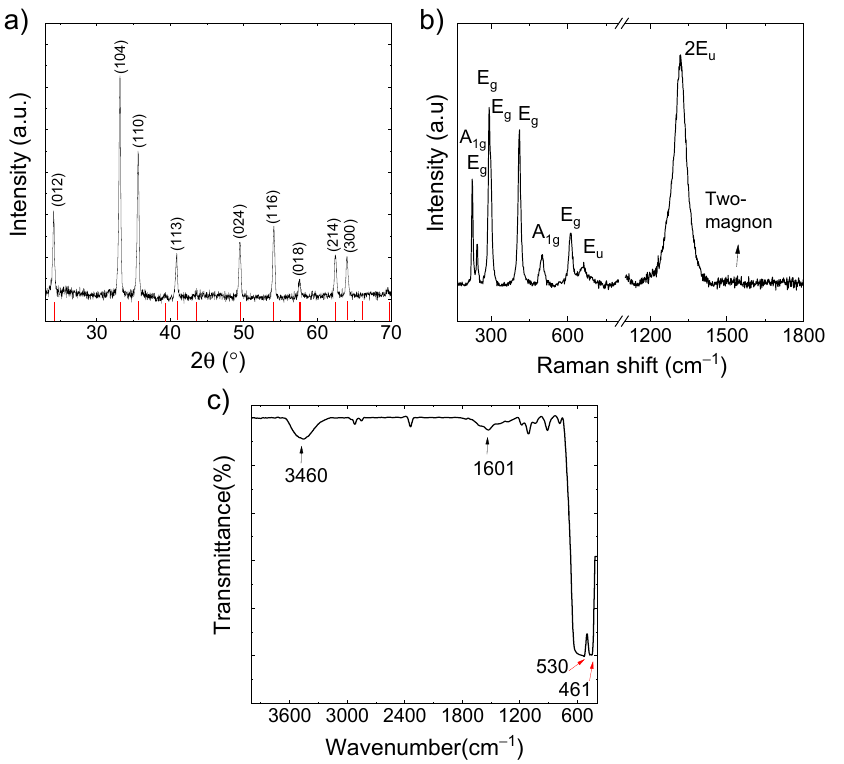
Figure 2. ( a ) XRD pattern; ( b ) Raman and ( c ) FT-IR spectra of the as-synthesized C-Fe 2 O 3 active material. In panel ( a ), the reference XRD pattern of α -Fe 2 O 3 (ICSD structure-22505) is also shown in red bars.